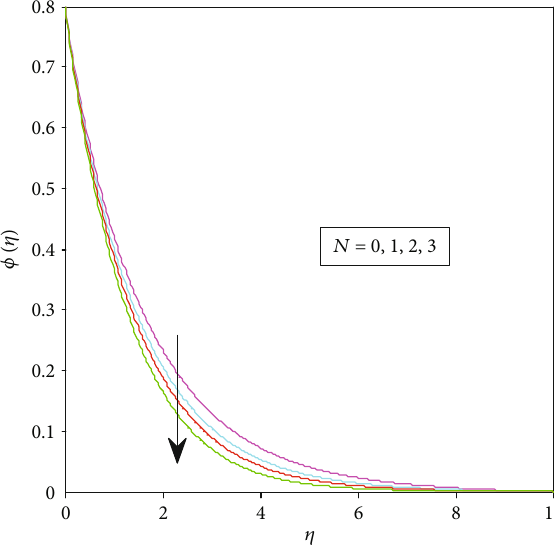
Figure 21: Concentration distribution for di ff erent values of the relaxation time of the mass fl ux.